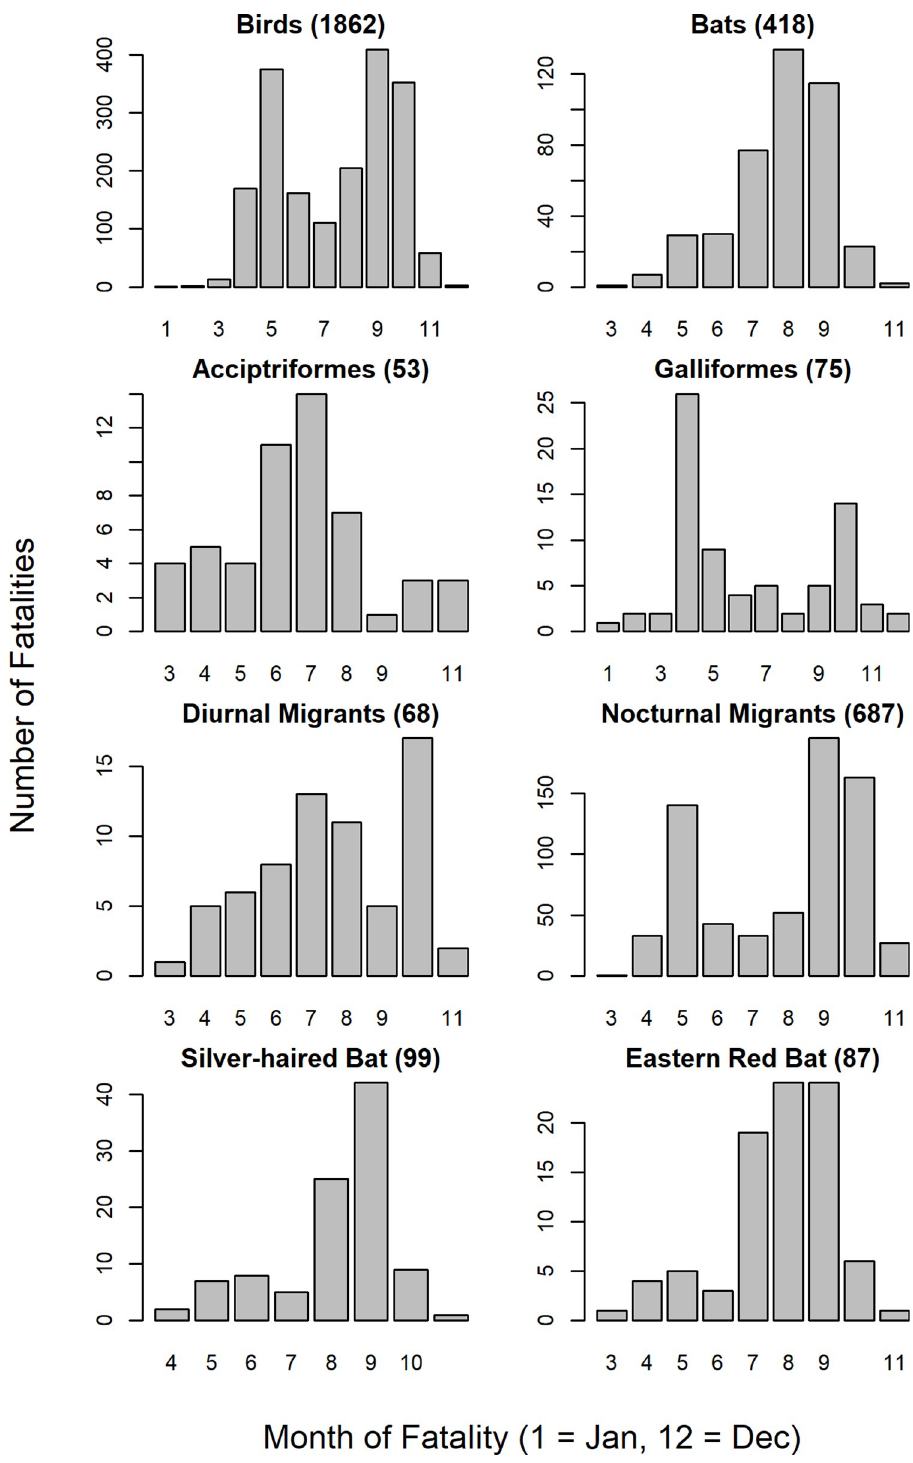
Fig 2. Fatalities per month for birds and bats, Accipitriformes (hawks and eagles) and Galliformes (ruffed grouse and wild turkey), golden-crowned kinglets and black-throated blue warblers, and silver-haired bats and eastern red bats. For monthly fatality histograms of the 10 most frequent families, see S1–S10 Figs.